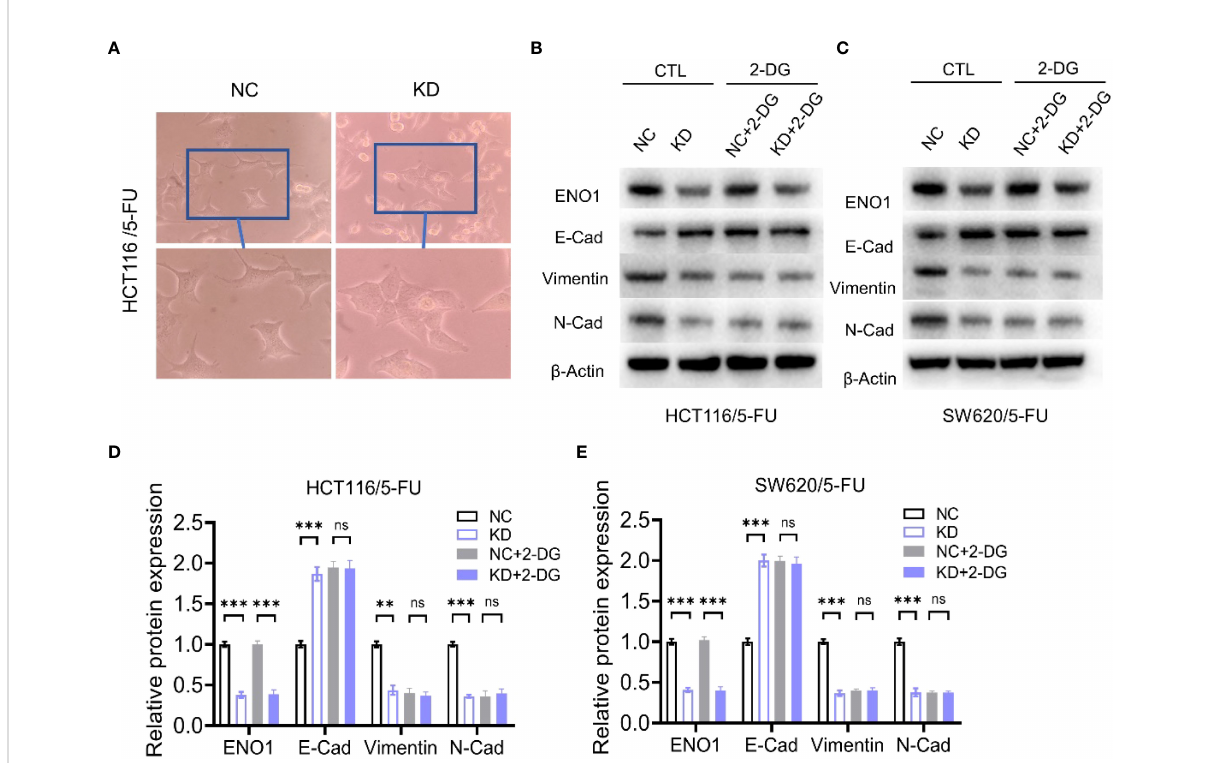
FIGURE 6 The regulation of the EMT process by ENO1 is associated with energy metabolism. (A) The morphological changes during the EMT process were suppressed in the ENO1-KD group compared with those in the NC group (observed by light microscope at 200× magni fi cation). (B, C) Western blotting of E-Cadherin, N-Cadherin, and Vimentin expression in NC and ENO1-KD groups treated with or without 20 mM 2-DG for 4 h in HCT116/5-FU cells (B) and SW620/5-FU cells (C). (D-E) The bands were quanti fi ed and are presented as mean ± SEM of three independent experiments in HCT116/5-FU cells (D) and SW620/5-FU cells (E) . Statistical analyses were performed via two-tailed Student t test. **, P ≤ 0.01; ***, P ≤ 0.001. ns, no signi fi